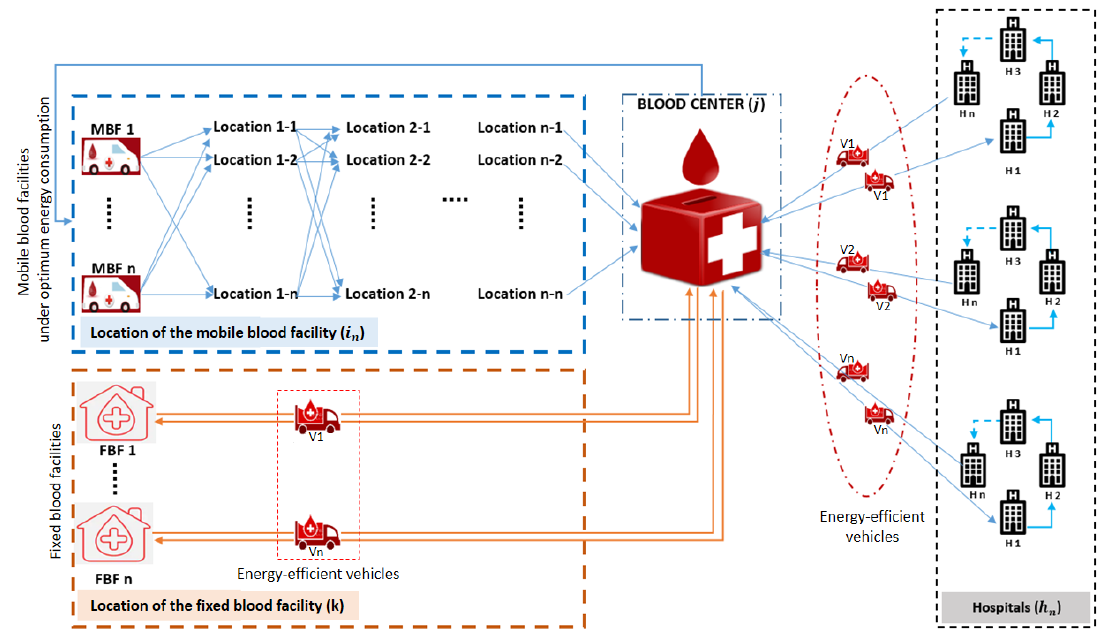
Figure 1. Platelet supply chain network with the effect of energy